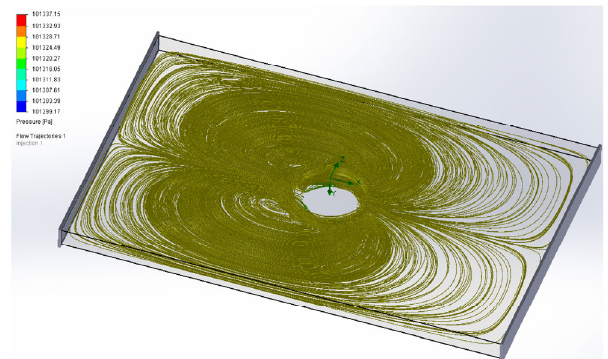
Fig. 3 Pressure distribution for v =0.08333 m/s in Tonna V68.